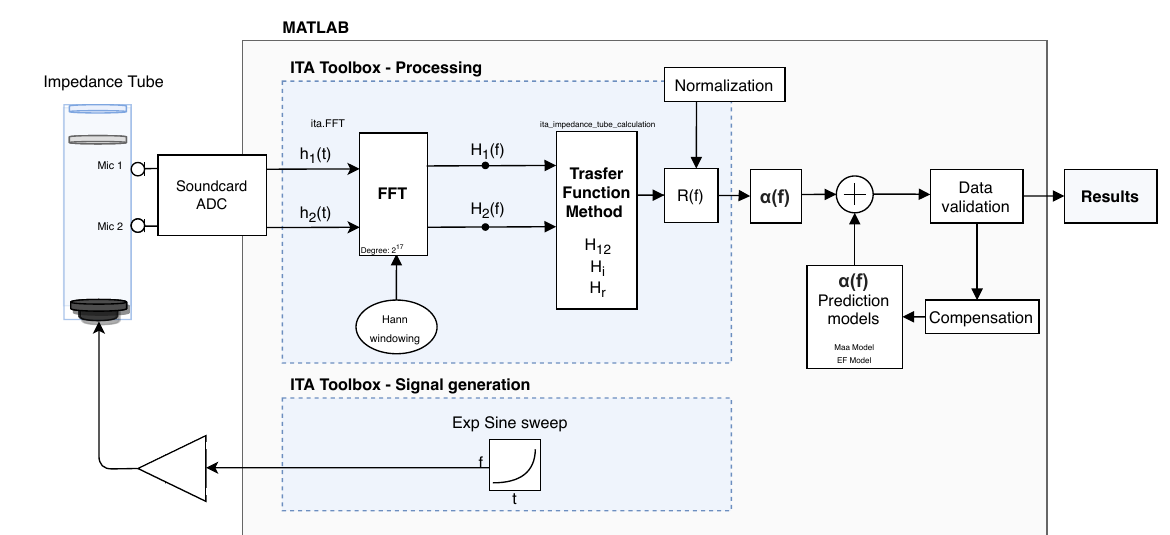
Figure 8. Data flow: excitation signal generation, acquisition of the impulse responses h 1 ( t ) and h 2 ( t ) , processing, compari- son with models, output of